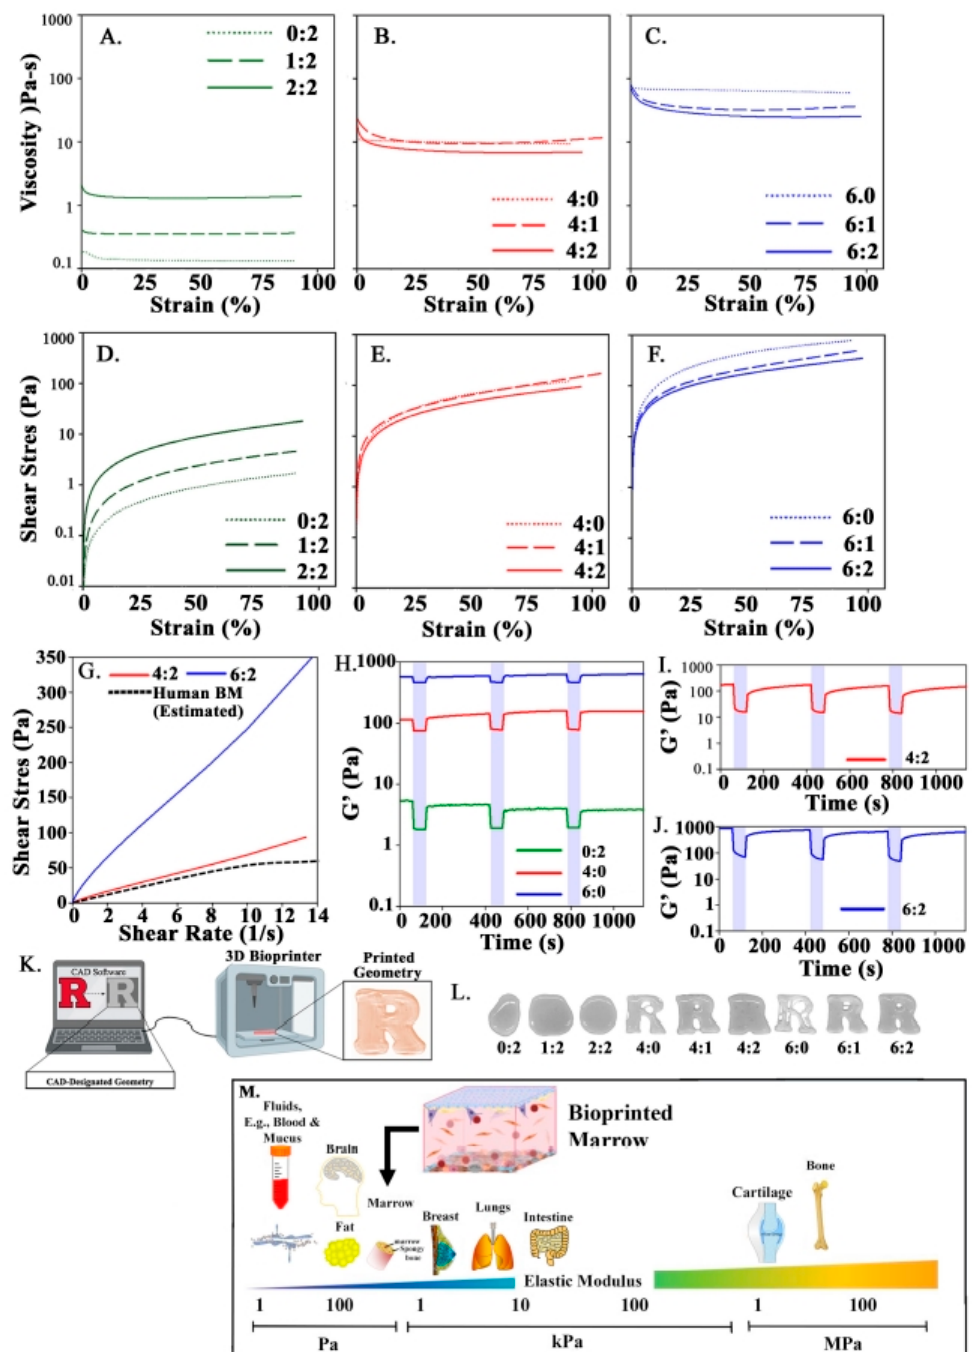
Figure 1. Rheological analyses of hydrogels. Strain sweeps were performed using oscillatory rheometry to measure viscosity ( A – C ) and flow ( D – F ) behaviors of hydrogels containing 0–2% ( w / v ) MC (green), 4% MC (red), and 6% MC (blue). ( G ) Flow curves for 4:2 (red) and 6:2 (blue) bioinks were compared to that of human BM from a 44 year old male reported by Sobotková [30]. Shear recovery analyses for ( H ) single component bioinks, ( I ) 4:2 bioink, and ( J ) 6:2 bioink. ( K ) Shape fidelity refers to the ability of a hydrogel to maintain the designated geometry once it is printed. ( L ) Assessment of shape fidelity of bioinks with printing of Rutgers University logo and assessing the gross degree to which the structures resembled the designated geometry. ( M ) Diagrammatic summary of the spectrum of elastic moduli (G’) of various bodily tissues and biomaterials as reported across the literature. Shown is femur, between 100 Pa and 100 kPa. The marrow is shown below 1 kPa, which is consistent with the perivascular and central niches.